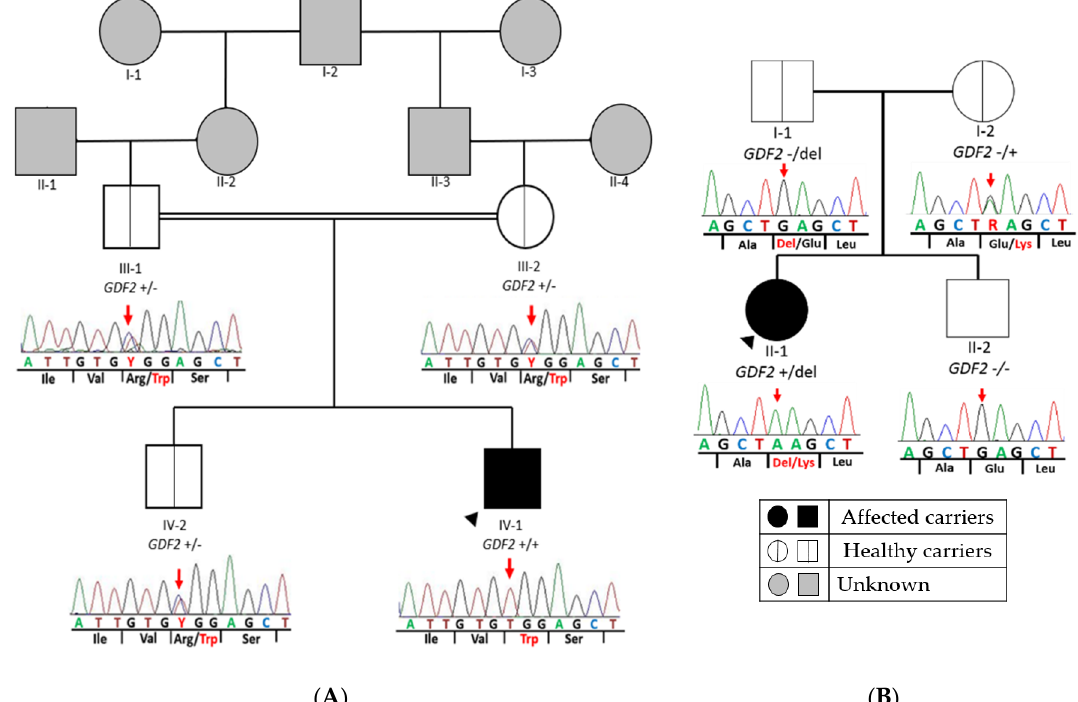
Figure 2. Pedigree of both families with GDF2 variants. Segregation analysis of GDF2 in all available family members. The figure shows a fragment of the GDF2 sequence with corresponding amino acids below. ( A ) Patient 1: It represents the homozygous missense variant at nucleotide position c.328 (c.328C > T) in exon 1 of GDF2 (NM_016204.3), which causes the amino acid substitution arginine to tryptophane at peptide position 110 (p.Arg110Trp) in the index patient. In addition, it shows the same heterozygous missense variant found in healthy parents and brother. ( B ) Patient 2: The missense variant at nucleotide position c.445 in exon 2 of GDF2 (NM_ 016204.4), which causes the amino acid substitution glutamine to lysine at peptide position 149 in the index patient and mother and the deletion inherited from her father. Double line denotes consanguinity. Legend: +/+ homozygous for the alternative allele; +/ − heterozygous for the alternative allele; del: